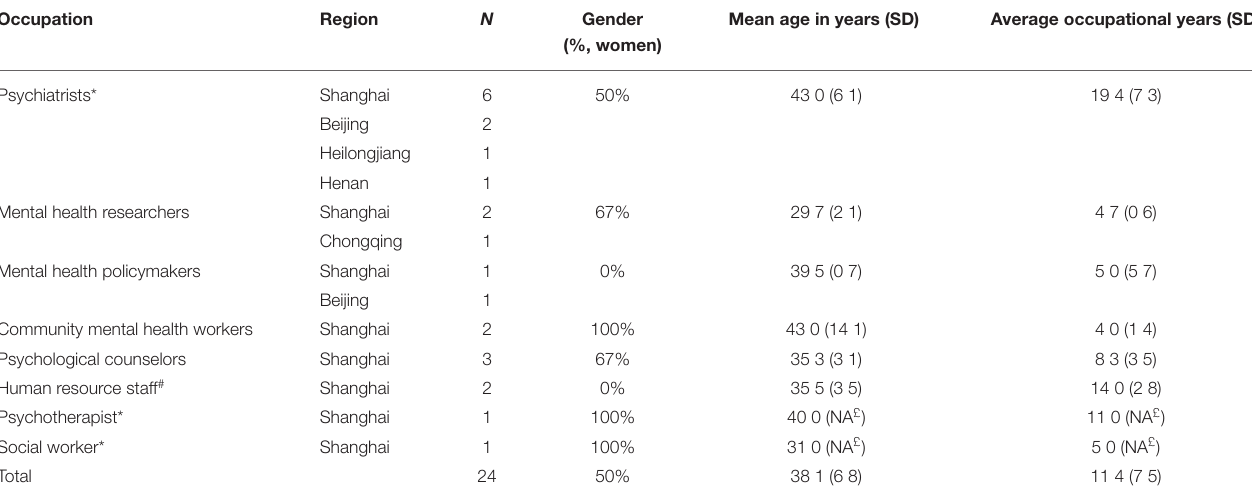
TABLE 1 | Characteristics of participants by occupation.